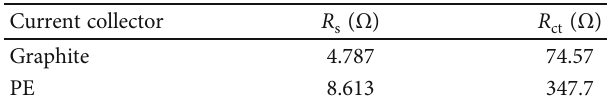
O //Zn at 4 C - rate (a) with di ff erent cathode current collectors (b) with di ff erent electrolytes 2 4 Table 1: Impedance parameters of equivalent circuit of LiMn O 2 4